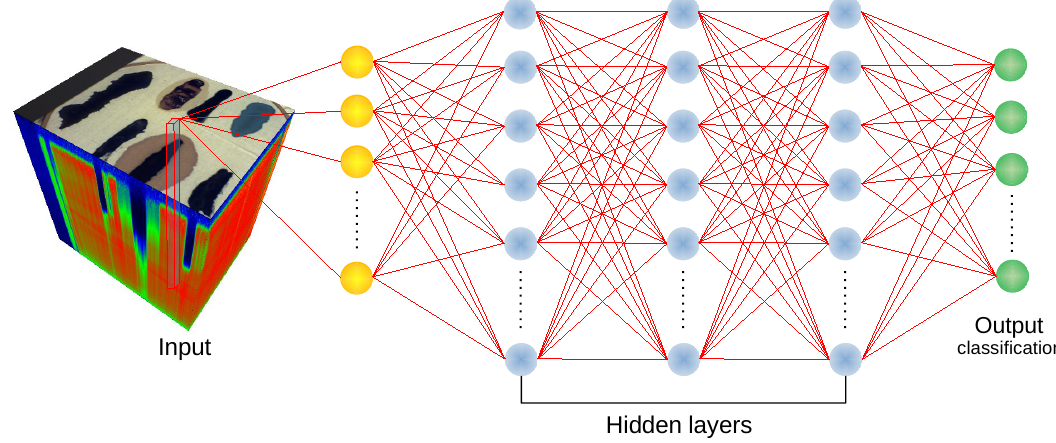
Figure 2. Schematic of the MLP architecture [19] used in